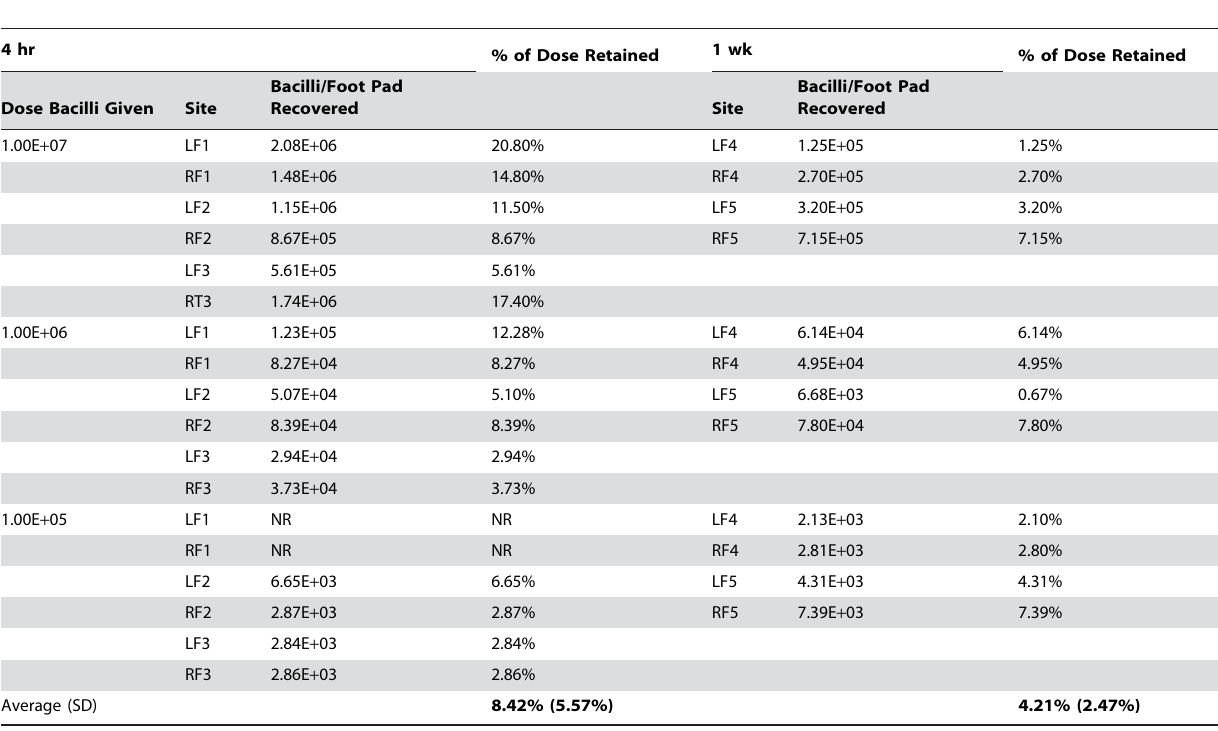
LF=Left Foot with dose animal number, RF=Right Foot with dose animal number, NR=Not Run. SD=Standard Deviation of average percent bacilli retained in the foot pad.